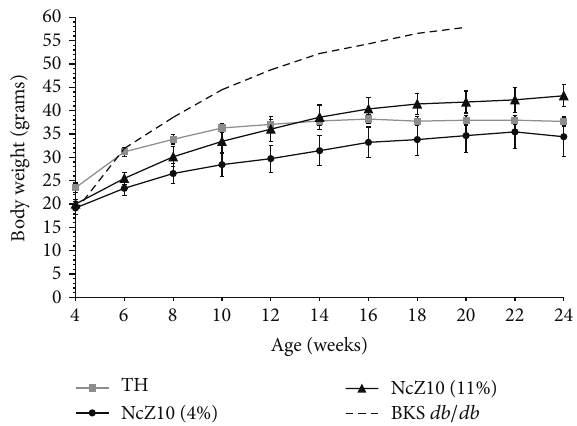
Figure 1: Comparative weight gains of groups of 20BKS- db/db and TH males fed standard 6% fat-containing chow, and the same number of NcZ10 males fed either 4% or 11% fat-containing chow. Data are means ± SD.